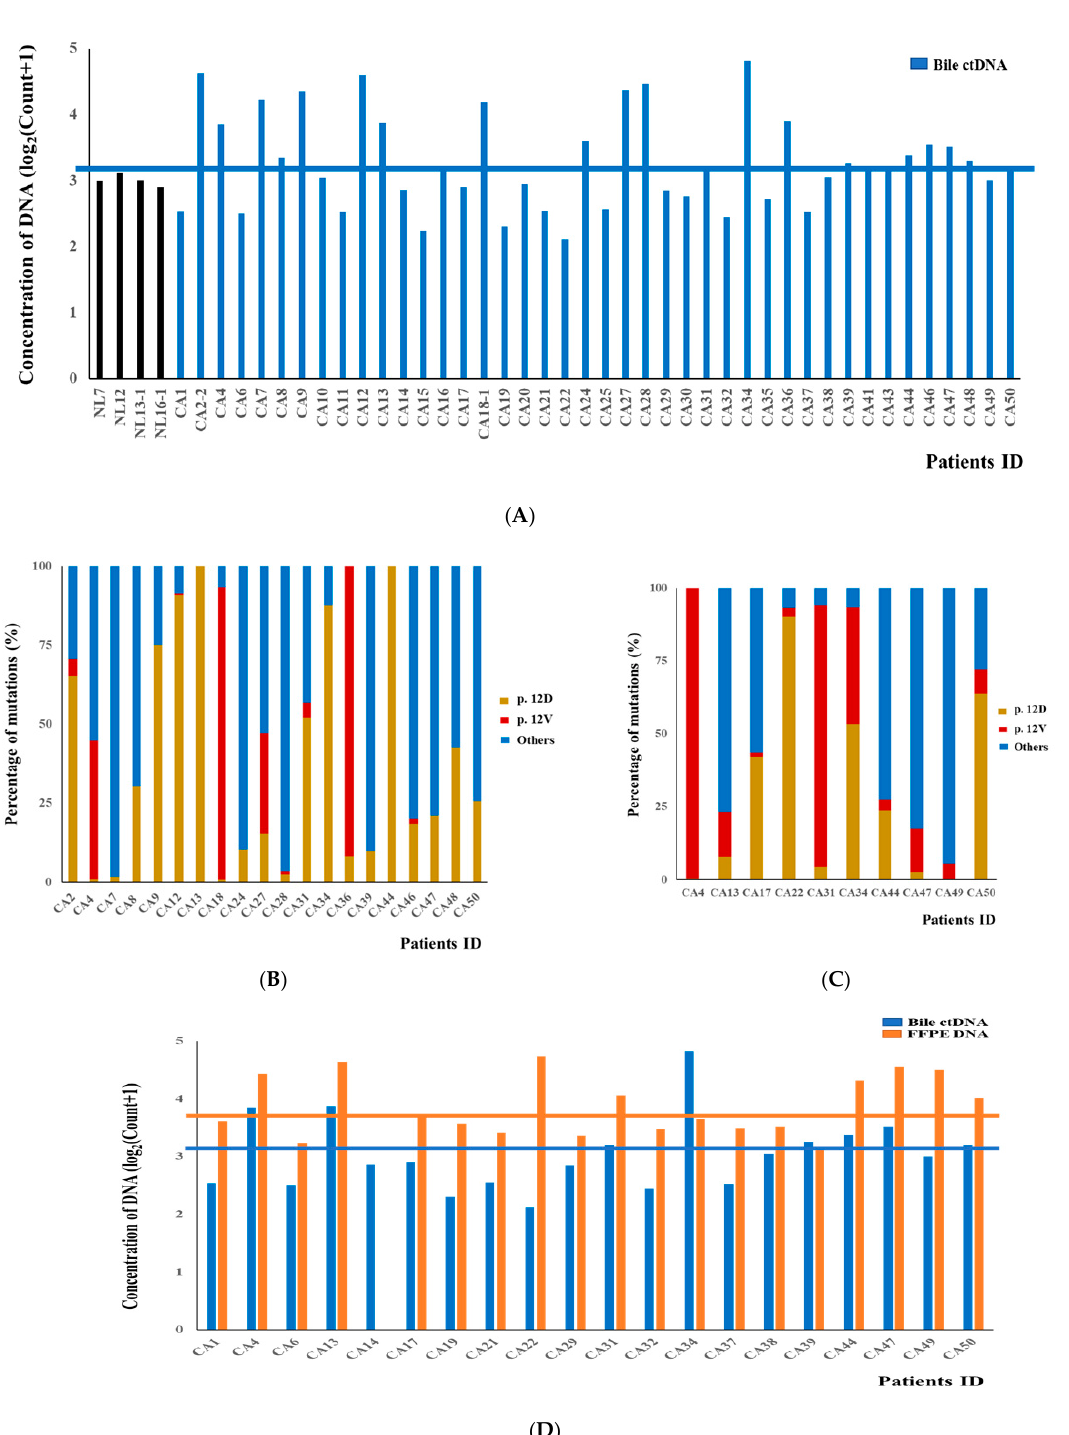
Figure 3. KRAS duplex assay and DNA concentrations in bile and FFPE samples. ( A ) KRAS duplex assay and ctDNA concentrations in all bile samples. Blue colored line indicates cut-off value for KRAS mutation in bile (1500 copies/mL). ( B ) Frequencies of G12D and G12V mutations in 20 patients with KRAS mutations in bile ctDNA. ( C ) Frequencies of G12D and G12V mutations in 10 patients with KRAS mutations in FFPE tissues. ( D ) Mutational concordance of KRAS between bile and paired FFPE samples (N = 20). Blue colored line indicates cut-off value for KRAS mutation in bile (1500 copies/mL) and orange colored line indicates that in FFPE (4500 copies/mL). The concentrations of mutant DNA (copies of mutant DNA per droplet) were estimated from the Poisson distribution. All panels show FAM amplitudes of up to 12,000 and HEX amplitudes of up to 12,000.